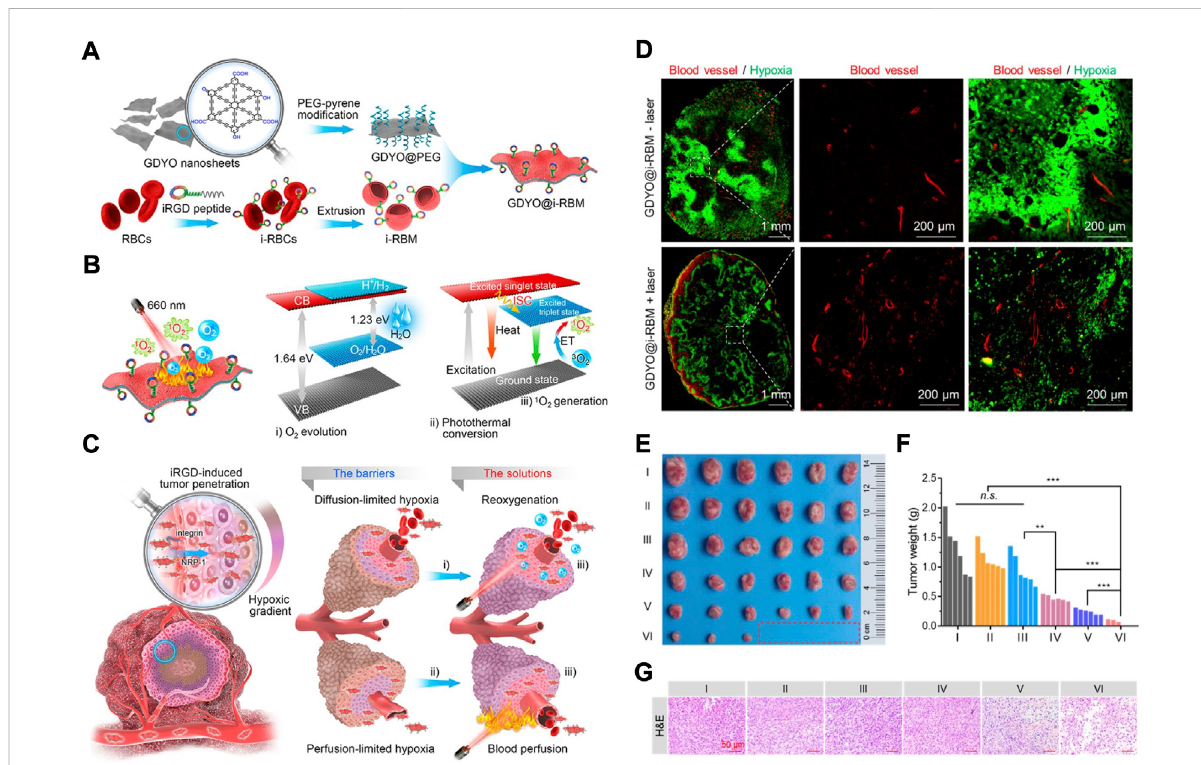
FIGURE 5 (A) The Scheme showing the synthetic process of GDYO@i-RBM. (B) The Scheme showing the working principles of GDYO@i-RBM: (C) The Scheme showing the reoxygenation process. (D) Immuno fl uorescence analysis of tumor sections stained with anti-CD31 antibody and anti- pimonidazole antibody after indicated treatments. (E – G) Photos (E) ; tumor weight (F) and representative images of H&E staining (G) of the tumor tissues after I – VI treatments (I: PBS-laser; II: PBS + laser; III: GDYO@i-RBM-laser; IV: GDYO@PEG + laser; V: GDYO@RBM + laser; VI: GDYO@i- RBM + laser). Statistical signi fi cance was calculated by two-tail Student ’ s t-test. * p < 0.05; ** p < 0.01; *** p < 0.001. Reprocessed with permission from ref 64. Copyright, 2019 American Chemical